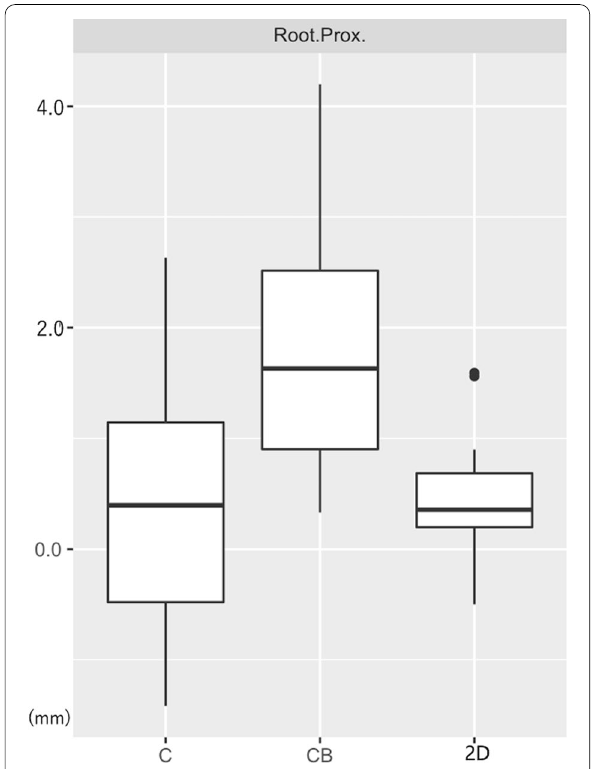
Fig. 3 Bar graph of root proximity (Root.Prox.) between groups (C: Control, CB: CBCT, 2D: 2‑dimensional